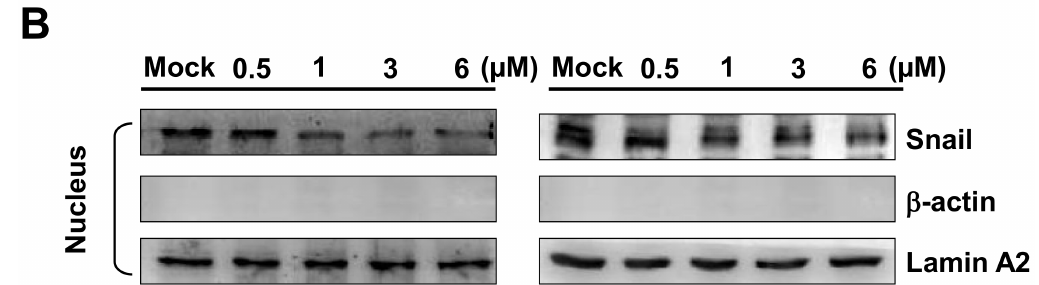
Figure 8. Suppression of epithelial to mesenchymal transition (EMT) by bornyl cis -4-hydroxycinnamate in A2058 and A375 cells. A2058 and A375 cells were treated with different concentrations of bornyl cis -4-hydroxycinnamate (0, 0.5, 1, 3, 6 µ M), and ( A ) cytosol and ( B ) nucleus proteins were collected separately for western blot analysis. EMT-related proteins N -cadherin, E -cadherin, and Snail were validated. The protein levels of N -cadherin and Snail were decreased, while that of E -cadherin was increased in A2058 and A375 cells after treatment with bornyl cis -4-hydroxycinnamate. β -actin and Lamin A2 were used as the internal controls separately for cytosol and nucleus proteins. Mock: control, DMSO-treated